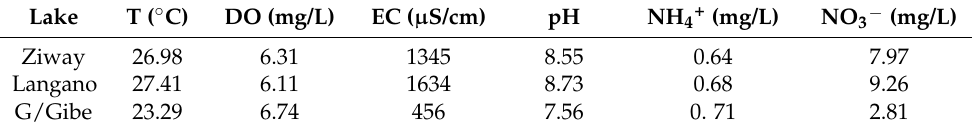
Table 2. Physicochemical water quality parameters of the three Ethiopian lakes in this study.